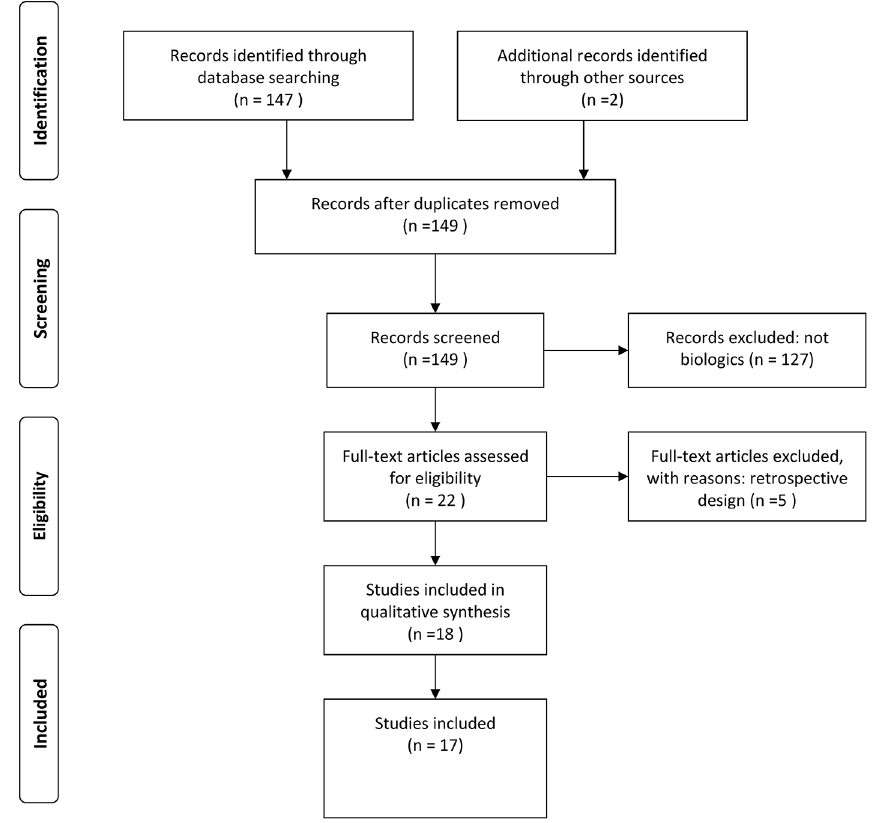
Fig 1. Flow diagram.